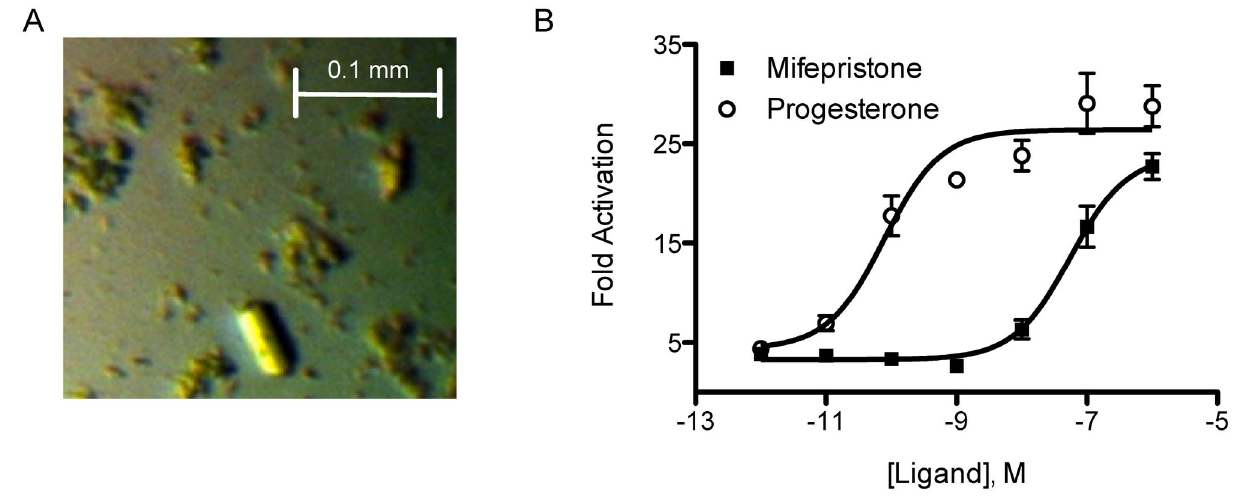
Figure 1. Crystals of the ancSR2–progesterone–mifepristone complex and in vitro activation data. A. The ancSR2– progesterone–mifepristone ternary complex crystals measured approximately 50 x 20 x 20 microns. B. In luciferase reporter assays, ancSR2 is strongly activated by mifepristone (EC = 56 ± 1.2 nM) as well as progesterone (EC = 78 ± 1.7 pM). 50 50 doi: